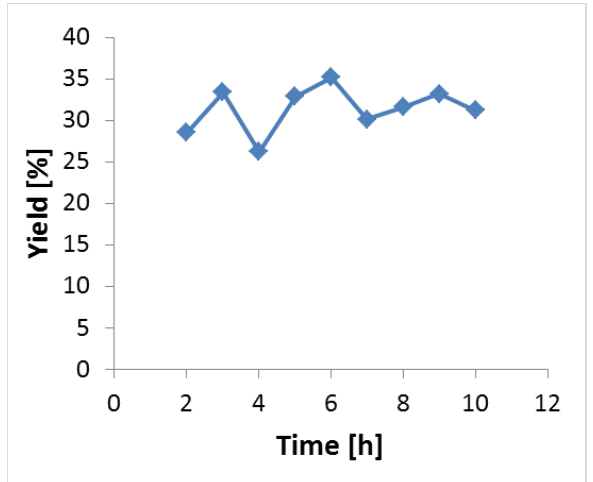
Figure 8: Long term enzyme stability at 70 °C. Reaction conditions: Reaction volume (0.250 mL), TA (1.1 mg, specific activity – 0.052 U/mg), flow rate (12.5 μ L/min), temperature (70